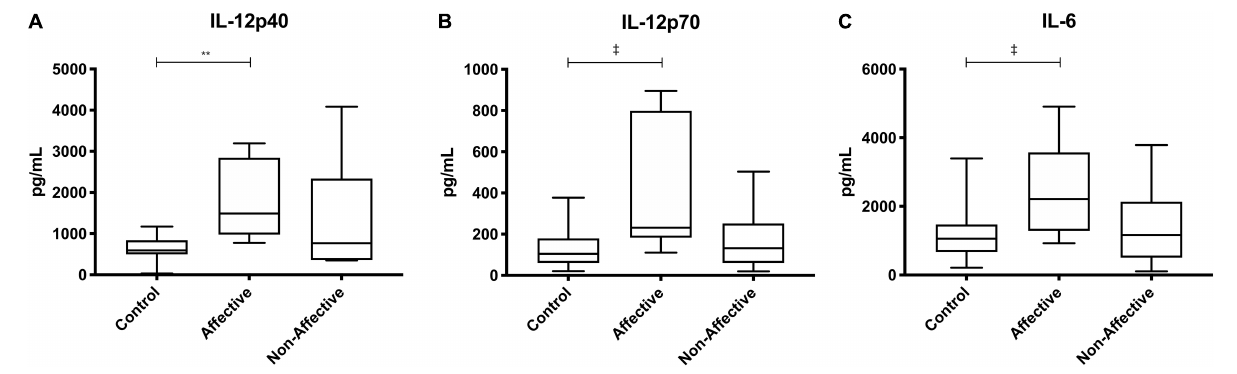
FIGURE 4 | Cytokine/chemokine levels after LPS plus IL-4 stimulation. Macrophage cytokine and chemokine production after culturing for 24 h in RPMI with 10 ng/mL LPS and 40 ng/mL IL-4. Macrophages from the AFF group produced higher concentrations of IL-12p40 (A) with trending increases in IL-12p70 (B)